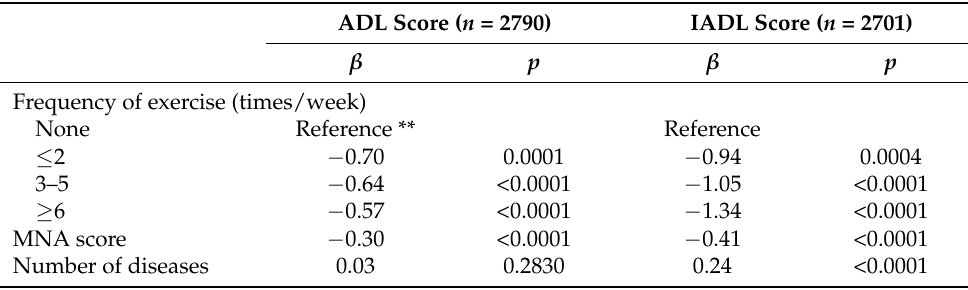
Table 2. Multivariate regression analysis of the cross-sectional associations * of frequency of exercise, MNA score and number of diseases with ADL and IADL scores in 1999. ADL Score ( n =